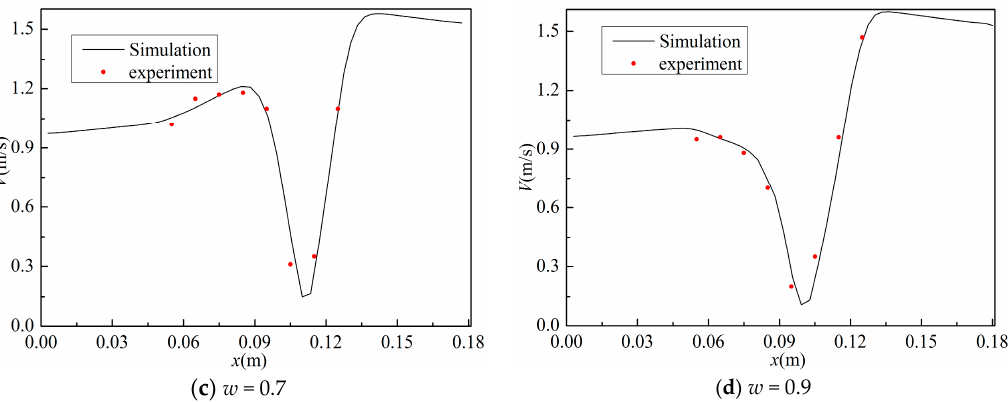
Figure 10. Instantaneous velocity magnitude on the axis of the nozzle in the xz plane, as determined by PIV and CFD for a sinusoidal inlet velocity at u m = 1.25 m/s, T = 0.4, A = 0.25 m/s, L / D = 4 and ∆ ϕ = T /2 in one period.